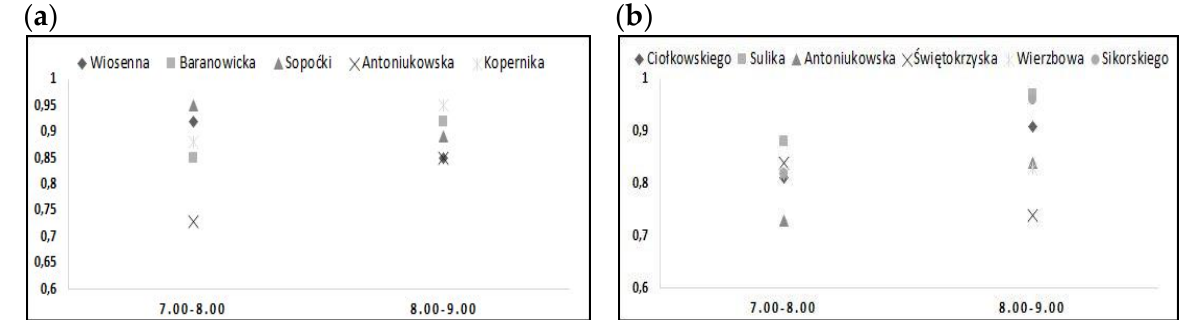
Figure 6. Peak hour factor ( a ) main routes ( b ) alternative routes. Visible irregularity in main (Kopernika and Antoniukowska streets) and alternative routes (Ciołkowskiego and Antoniukowska streets) correlated with higher upstream traffic and is validated by k15 values. A large discrepancy of PHF values (Figure 6) along with increasing and decreasing trend in traffic volumes in peak hours indicate the randomness of the irregularity phenomena rather than its regularity caused by TTI information displayed on the VMS. This also confirms that everyday traffic volumes are subjected to some natural fluctuations which in most cases are statistically insignificant though (Table 3).